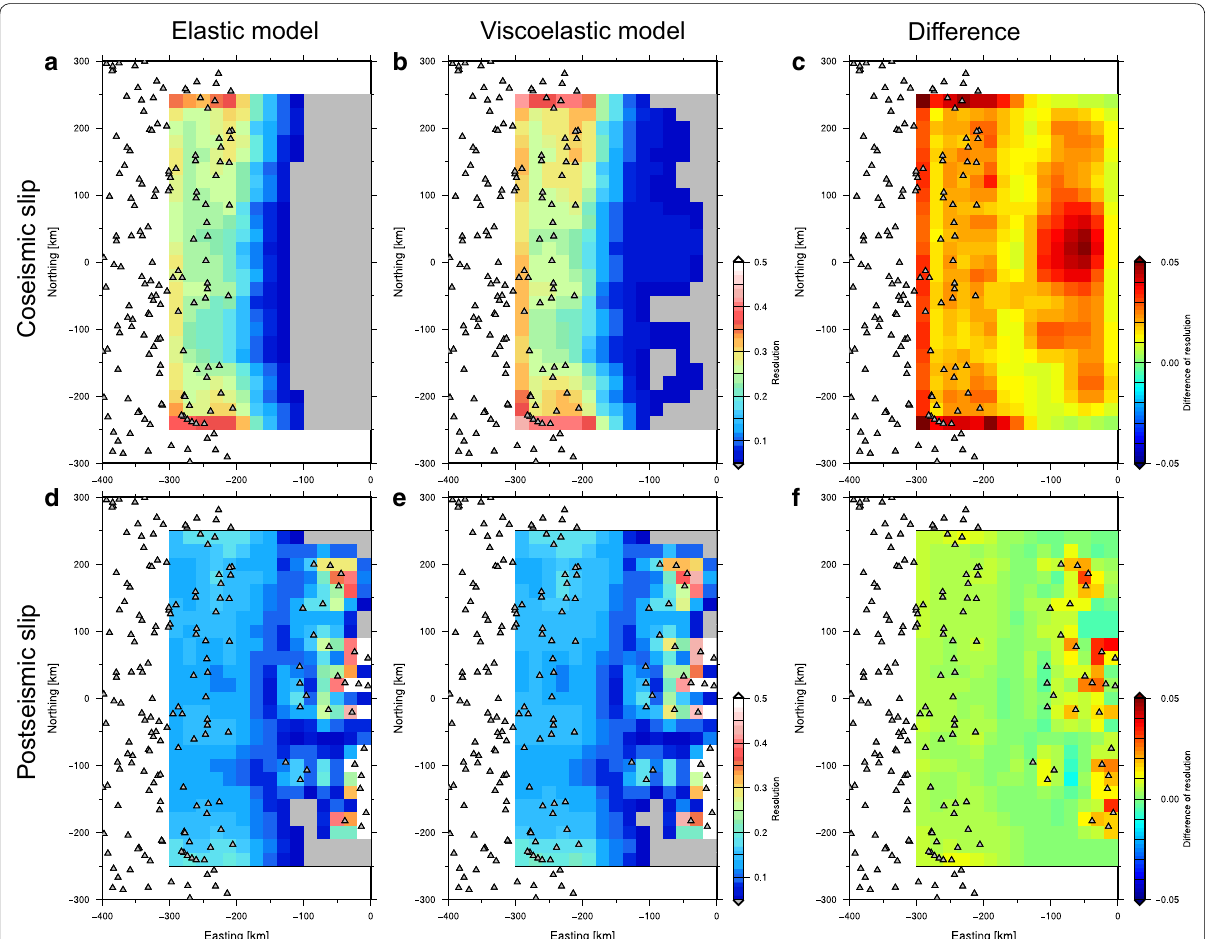
Fig. 9 Resolution for the dip–slip case. a , d The spatial resolution of the co- and post-seismic slip distributions in the elastic model for the dip–slip case, respectively. b , e The spatial resolution of the co- and post-seismic slip distributions in the viscoelastic model for the dip–slip case, respectively. c , f Respectively show the spatial resolution of the co- and post-seismic slip distributions subtracting that in the elastic model from that in the viscoelastic model. Gray triangles show the same as with Fig.